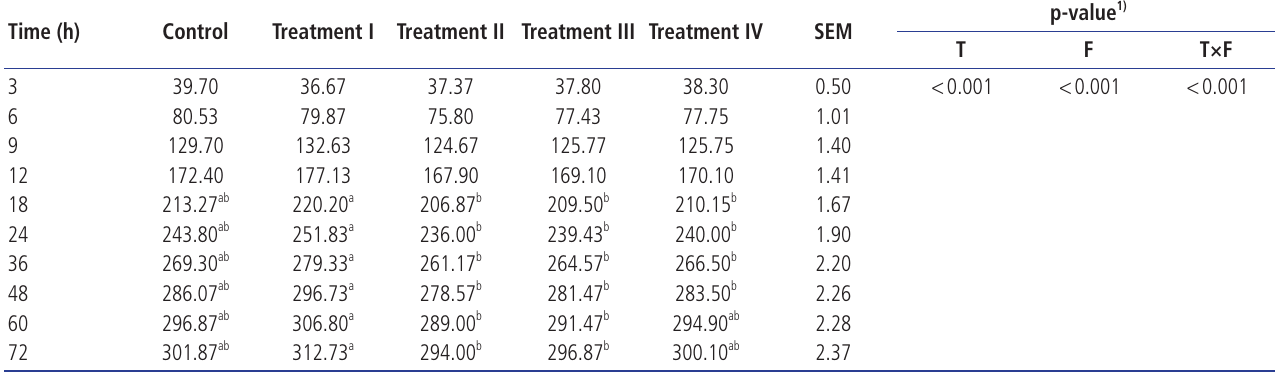
SEM, standard error of the mean. 1) T, effect of treatments; F, effect of fermentation time; T×F, interaction effect of treatments and fermentation time. a,b Within the same row with different lower-case letters mean significant at